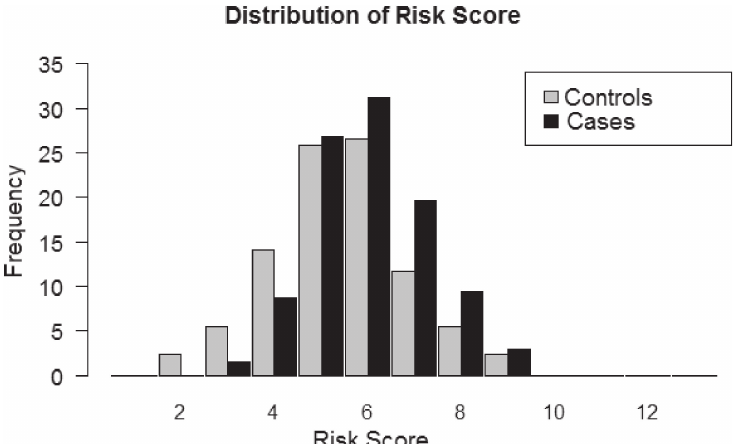
Figure 1. Distribution of North African individuals according to the number of risk alleles in the sample of cases and controls analyzed.